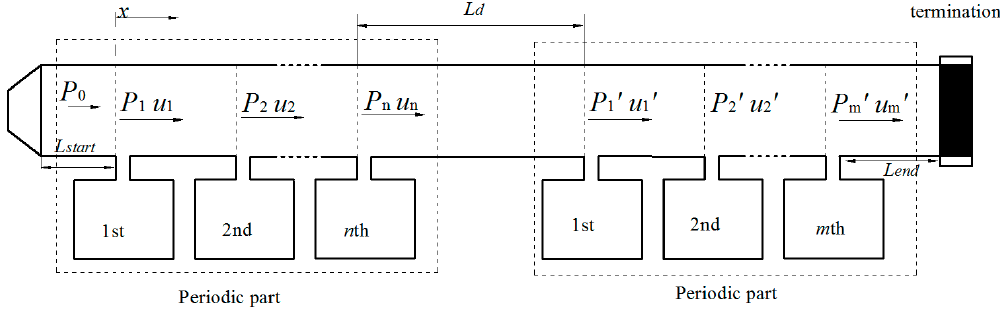
Figure 3. A ducted HR system consist of several periodic parts.